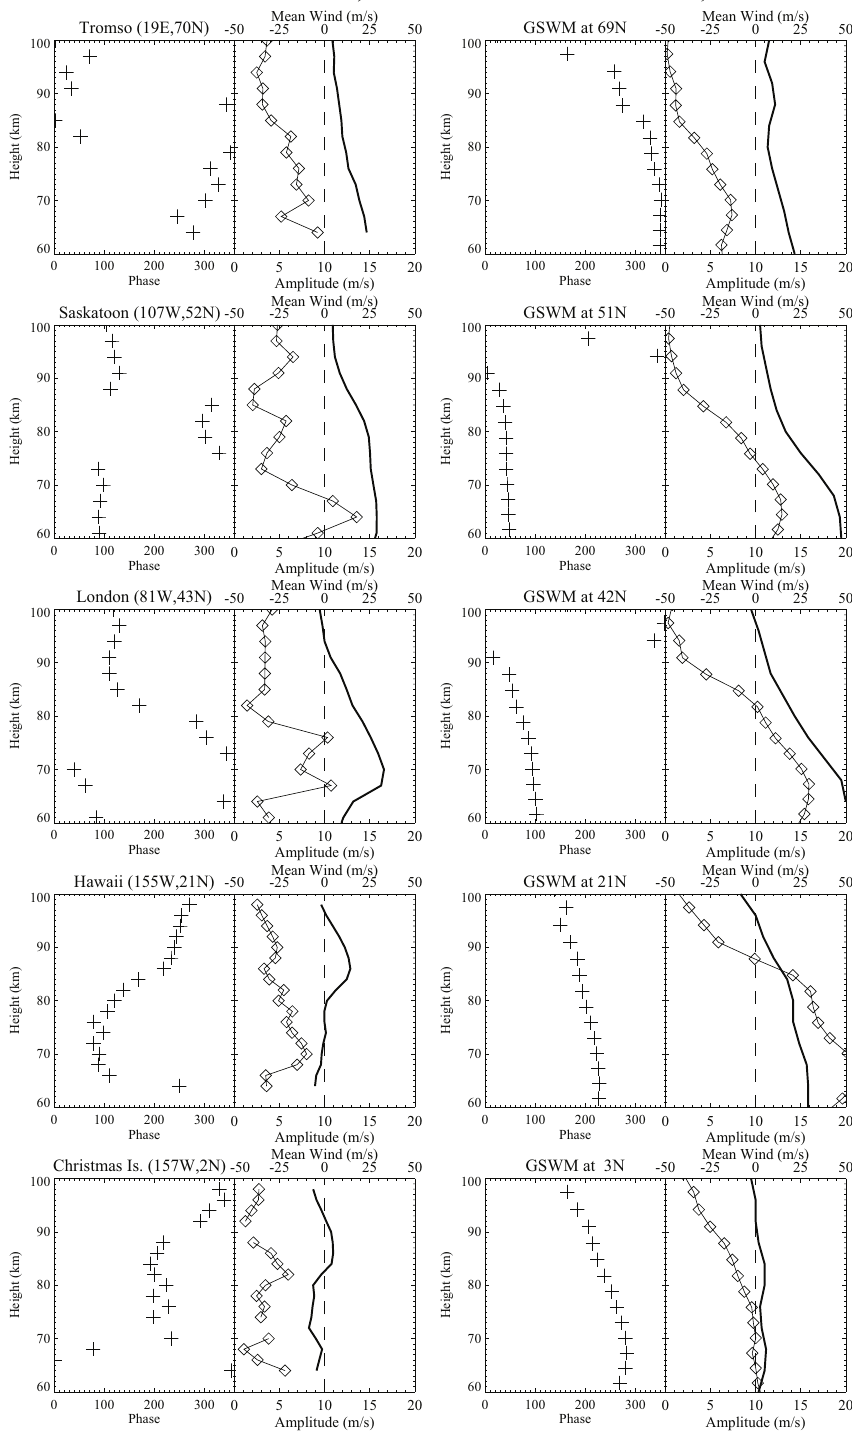
Fig. 9. The phase and amplitude profiles (60–100km) for the zonal 16-day wave in the winter of 1994 at five locations, and the corresponding results from the GSWM. The spectral phases for winds at different locations are all calibrated to the zero-longitude according to westward propagation of zonal wave number 1. The phases are denoted by cross symbols and the amplitudes by connected diamonds. The mean wind profiles are also provided by thick